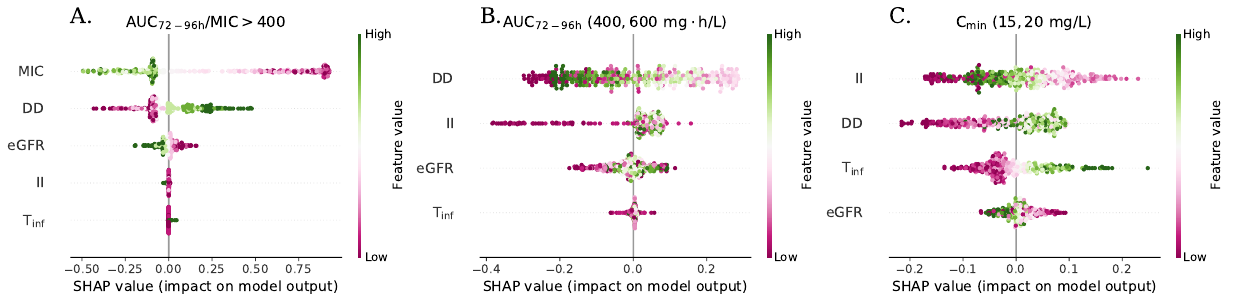
Figure 5. SHAP summary plots for the artificial neural network models created. ( A ) Index AUC 72 − 96h /MIC ≥ 400. ( B ) Index AUC 72 − 96h between 400–600 mg · h/L. ( C ) Index C SS 15–20